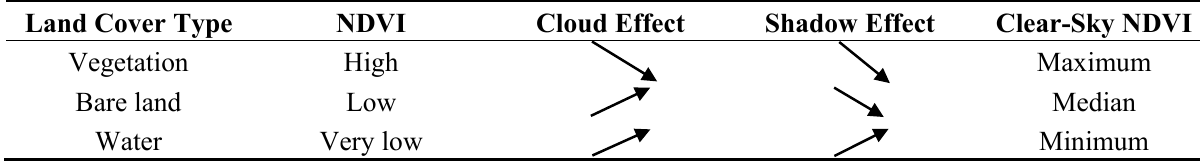
Table 1. Summary of the impacts on NDVI from clouds and cloud shadows over different land cover